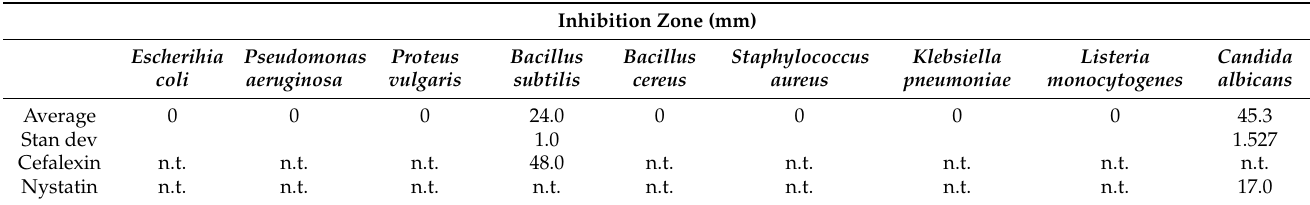
Table 5. Antimicrobial activity of fennel essential oils